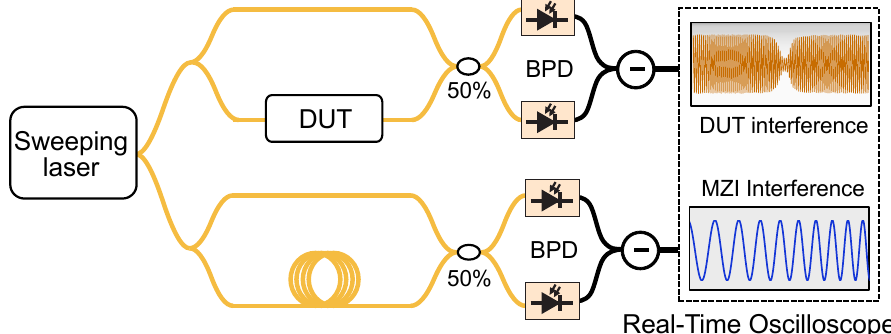
Figure 5. Schematic experimental setup of SWI of a DUT. Auxiliary interferometer (without DUT) assists in tracking and compensation of laser’s sweep